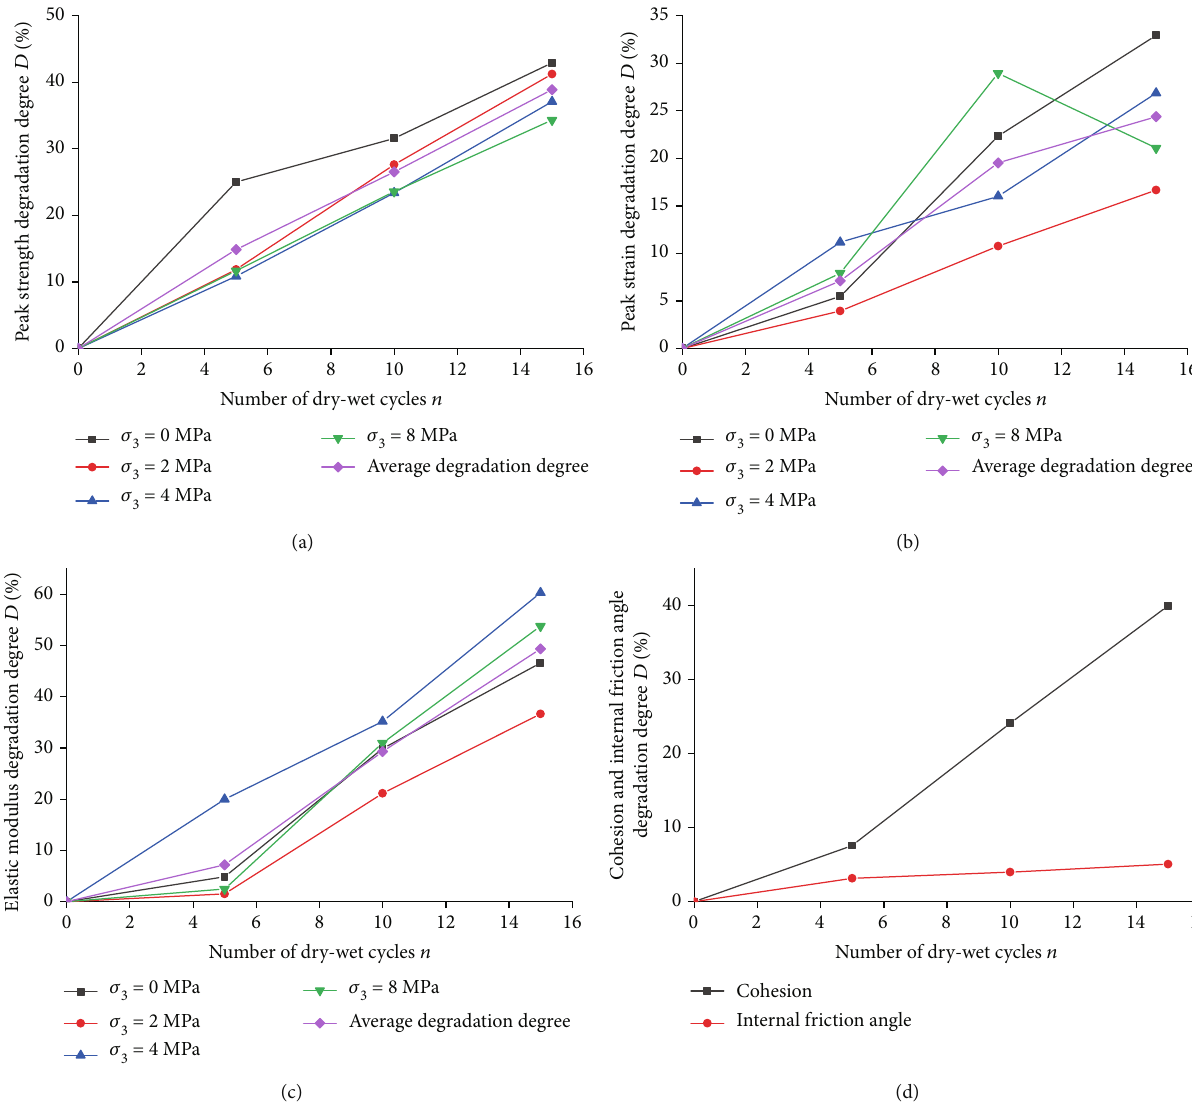
Figure 9: Variation of mechanical parameter deterioration